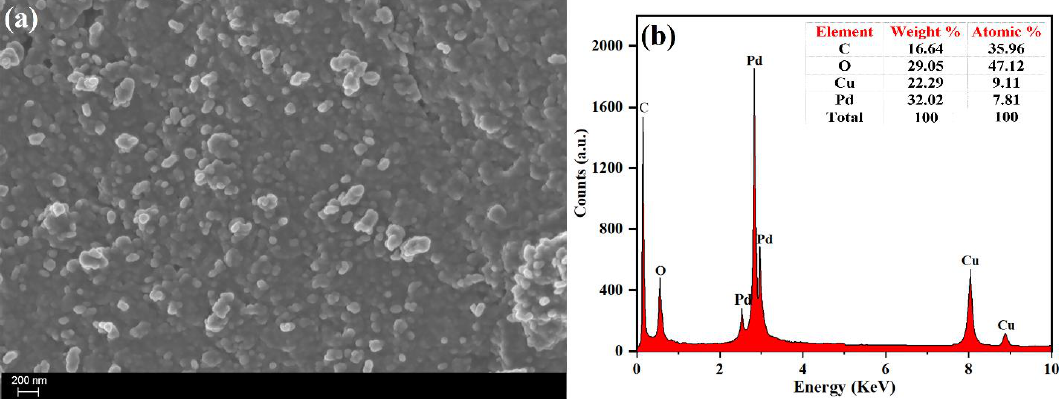
Figure 6. ( a ) Scanning electron microscopy (SEM) image, and ( b ) EDX spectrum of PdNPs.